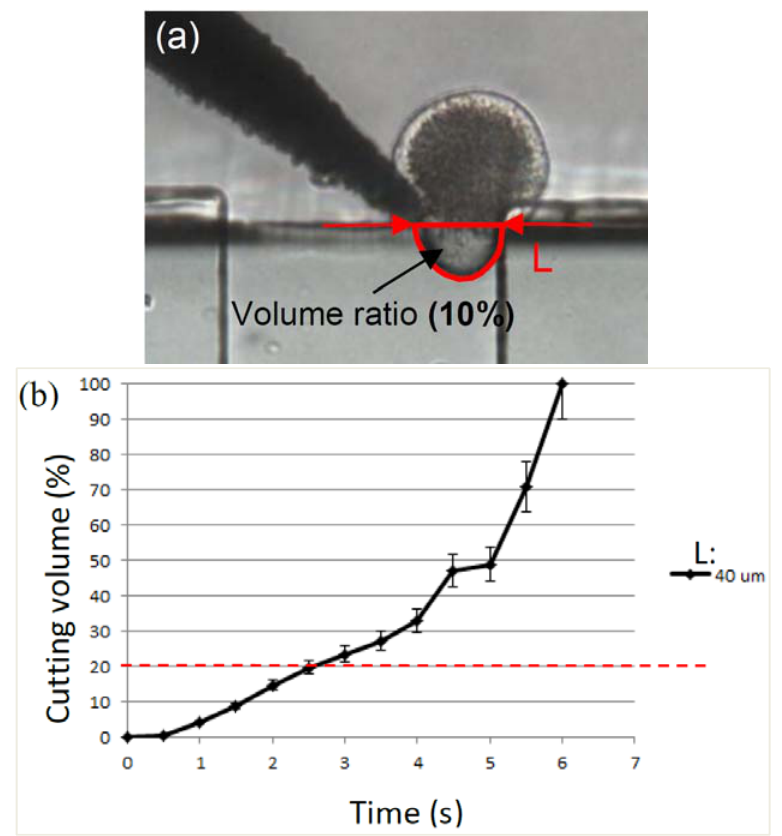
Figure 4. Correlations of the volume sucked into the outlet microchannel with respect to the time under the fixed position of the MMT. The velocity of the outflow is set to 3.5 mm/s. ( a ) The definition of volume ratio, ( b ) the experimental